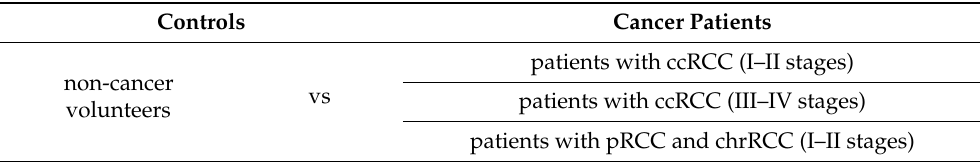
Table 2. Groups of samples for comparative